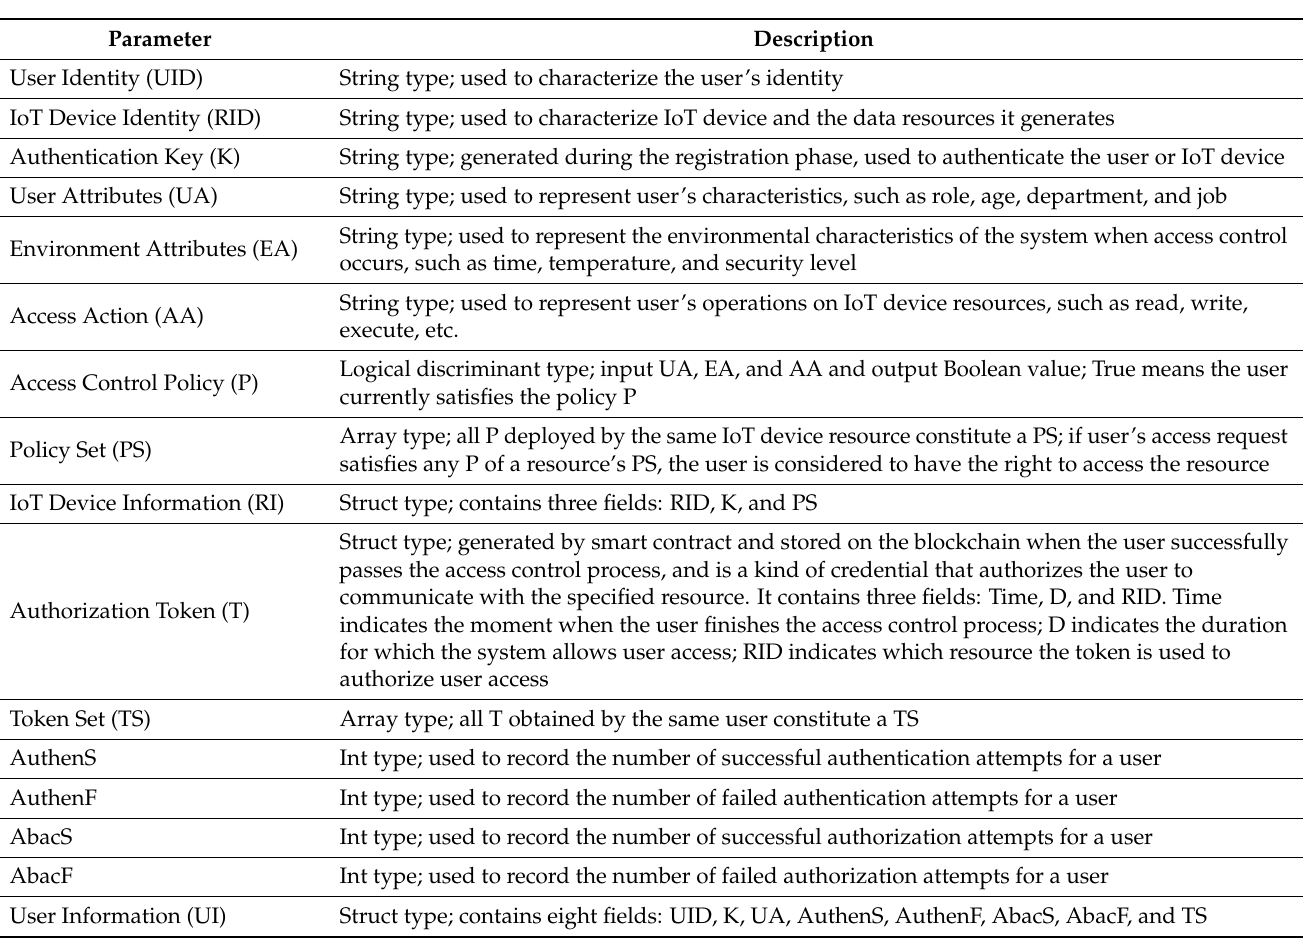
Table 1. Description of